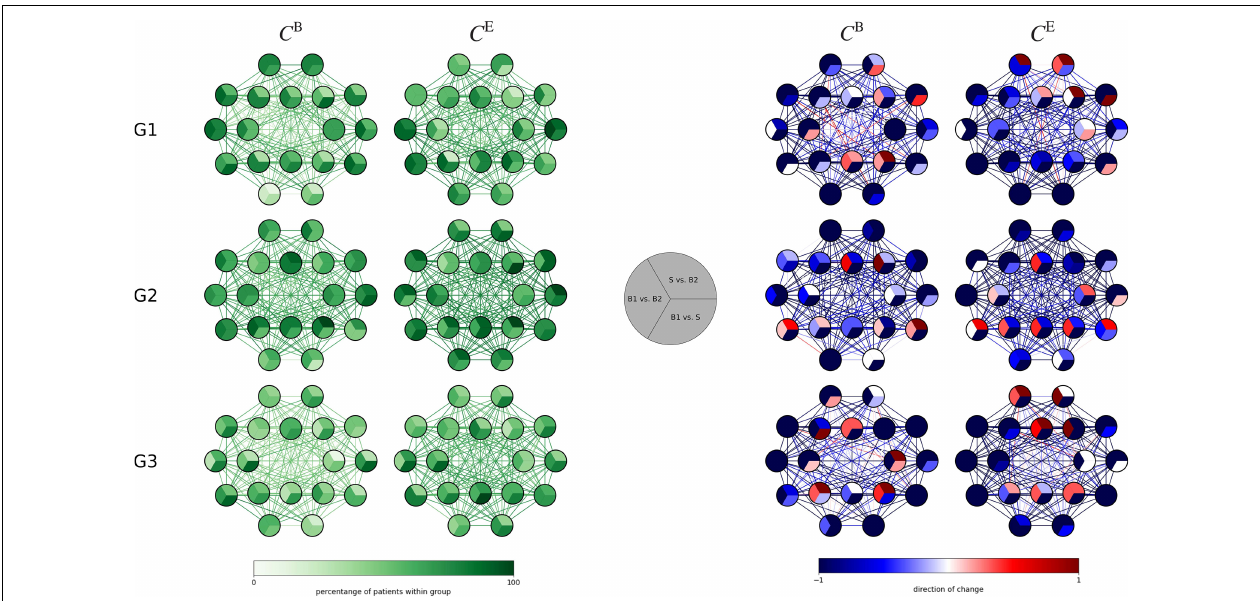
FIGURE 4 | (Left) Distributions of taVNS-related alterations in local network characteristics (betweenness centrality C B and eigenvector centrality C E ) of the three investigated groups (G1 = focal epilepsy group, G2 = generalized epilepsy group, G3 = non-epilepsy group) between the three investigated phases (B1 = pre-stimulation baseline 1, S = stimulation, B2 = post-stimulation baseline 2). Network vertices arranged according the international 10–20 system for EEG-recording. Color coding of vertices and edges according to the percentage of subjects for whom significant changes in local network characteristics were observed on per subject base. (Right) Differences between phases (B1, S B2) for local network characteristics in the three investigated groups. Color coding of vertices and edges according to the direction of change of importance for vertices and edges (per subject base).